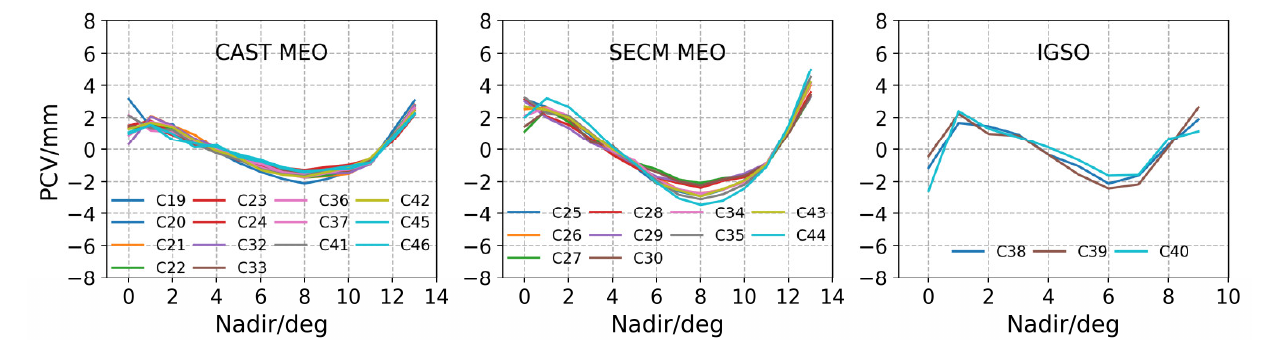
Figure 9. Satellite-specific PCV of the 2-Step Scheme. Table 4. Final PCVs for each satellite of the 3-Step Scheme, the unit is mm.